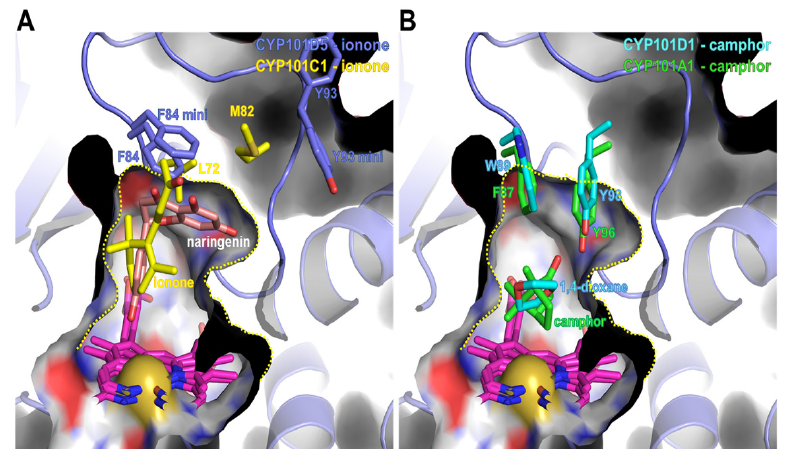
Figure 7. Substrate binding site of CYP101D5 and a comparison of residues consisting of the binding sites of three CYPs from the CYP101 family. The substrate binding site is denoted with a yellow dotted line. ( A ) Ionone-preferring CYPs; CYP101D5 and CYP101C1 are superposed. ( B ) Camphor- binding CYPs are aligned with the CYP101D5 structure. Key residues at the substrate binding site are highlighted with sticks. Residues from the energy-minimized structure of CYP101D5 are indicated and compared with the crystal structure.